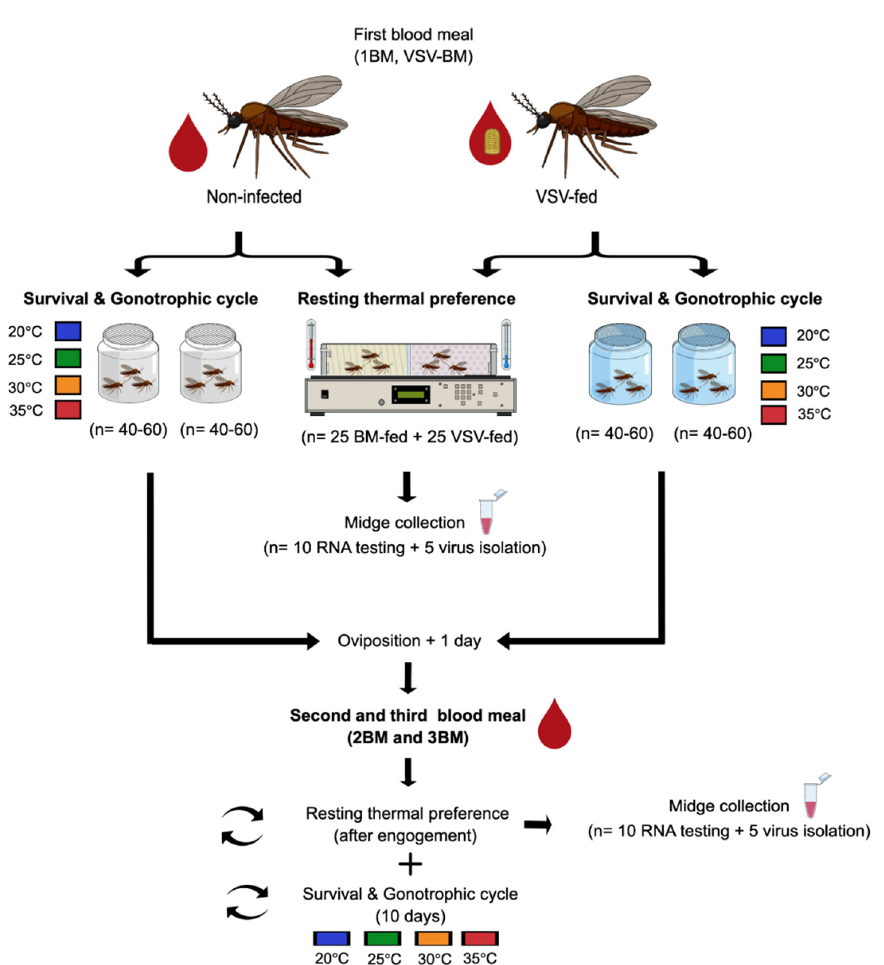
Figure 1. Experimental design to test constant temperature-mediated effects on post-engorgement resting temperature preference, midge survival, gonotrophic cycles, and VSV infection.